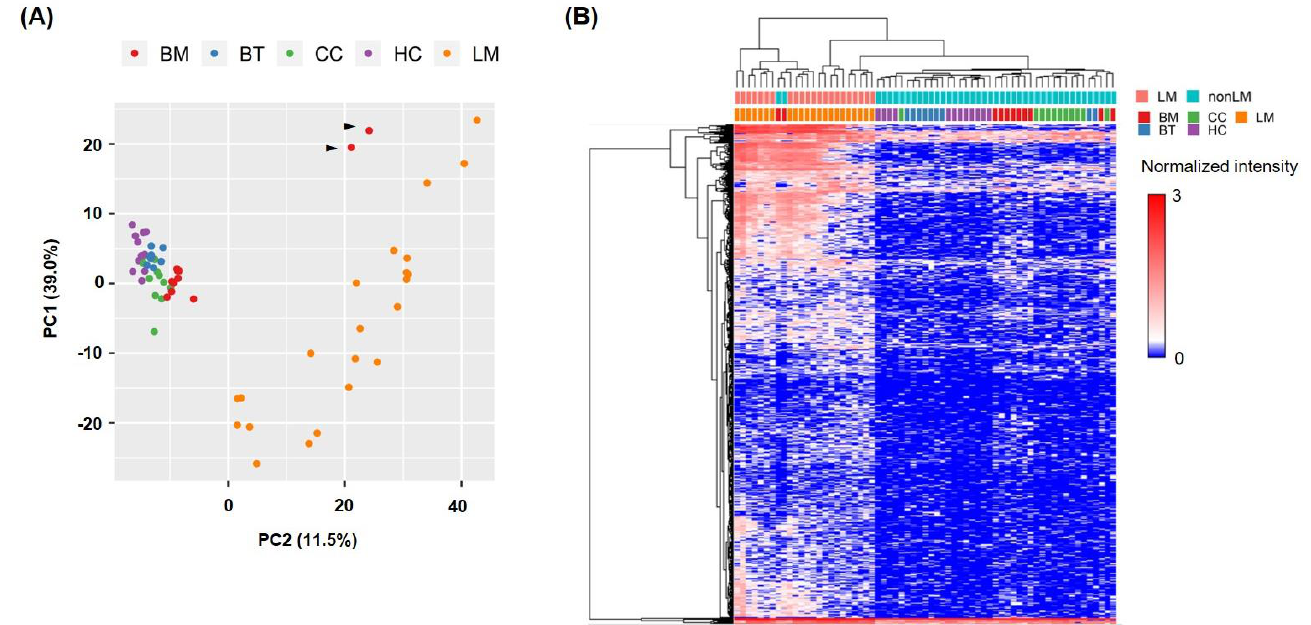
Figure 2. CSF miRNA profiling can distinguish the leptomeningeal metastasis group from the other CNS tumor groups. ( A ) Principal component analysis (PCA) of the microarray data. Black arrows indicate two BM samples. ( B ) Unsupervised hierarchical clustering analysis. A total of 998 mature miRNAs (group FDR F-test, p < 0.05) were selected, and k-means clustering method was used to generate dendrograms. Abbreviations: BM, brain metastasis; BT, brain tumor, CC, cancer control; HC, healthy control; LM, leptomeningeal metastasis.